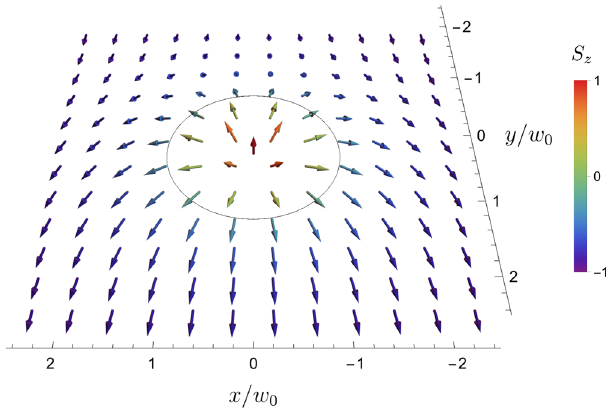
Fig. 1 Optical excitation of a baby-Skyrmion. The baby-Skyrmion has a characteristic fountain-like structure in the atomic Stokes vector S (Eq. (4)), generated by the light fi eld of Eq. (2), with beam width w 0 . S points along the z ( − z ) direction at the origin (large distances from the origin), ffiffiffi p and lies in-plane at the radius ρ ¼ w 0 = 2 (black circle), corresponding to the poles and equator of the Poincaré sphere, respectively. For illustrative purposes, we choose a regular square array for the atomic ensemble, but any geometry can be